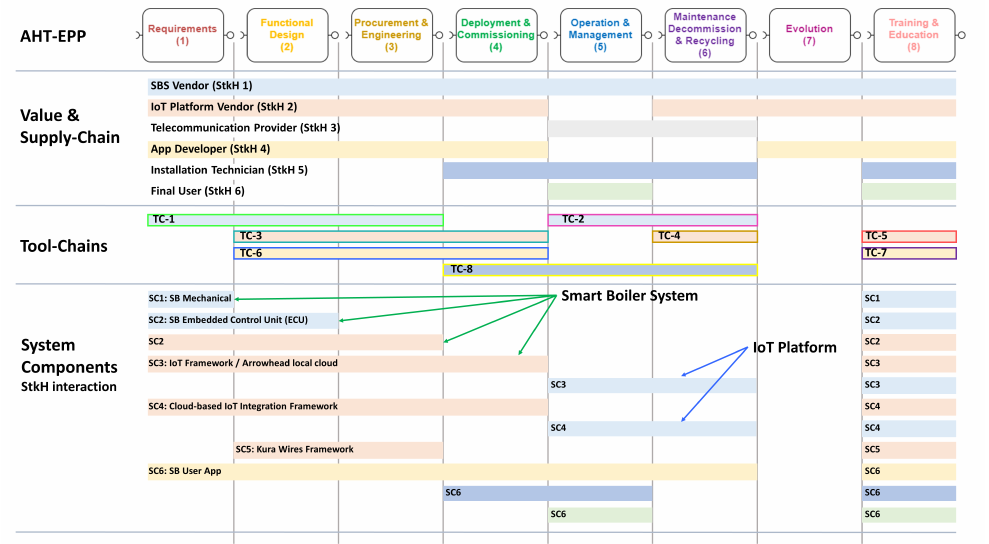
Figure 9. VCEP map describing the smart boiler system value chain for each Arrowhead-EP phase